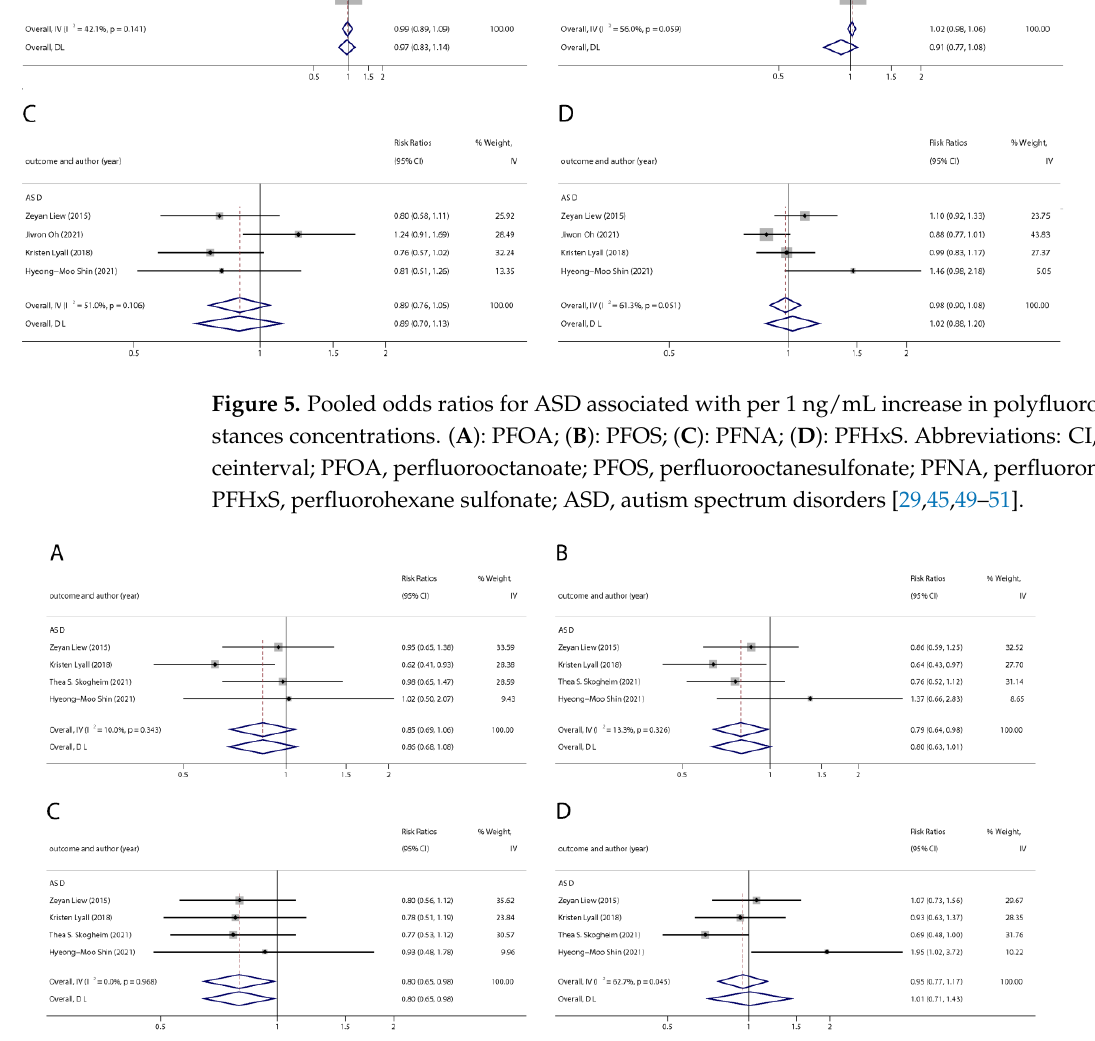
Figure 6. Pooled odds ratios for ASD associated with polyfluoroalkyl substances concentrations